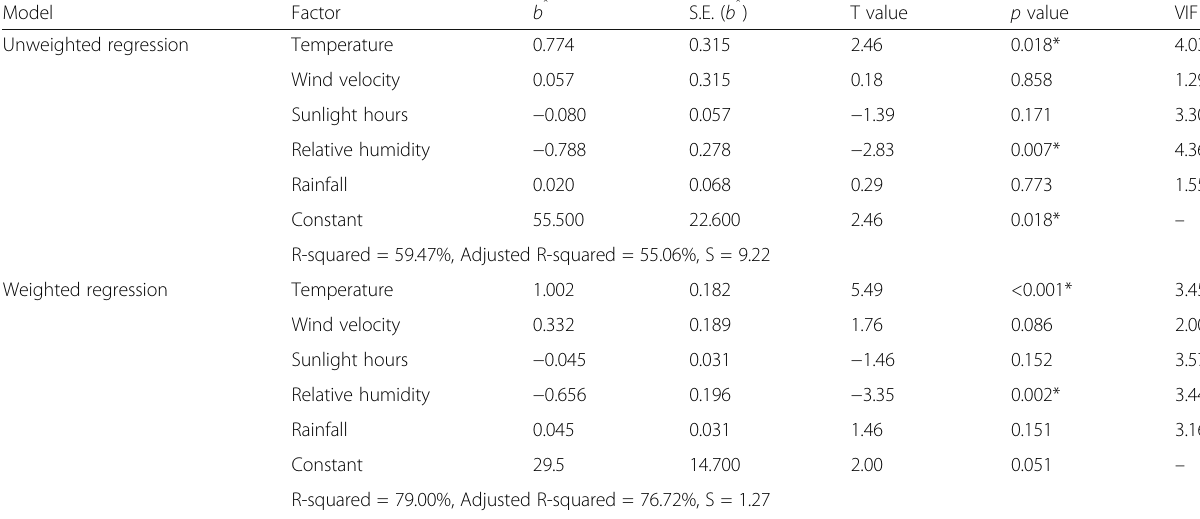
Table 5 Factors associated with monthly scorpion sting distribution for the study population via regression analyses per year (scorpion sting rate is response variable)